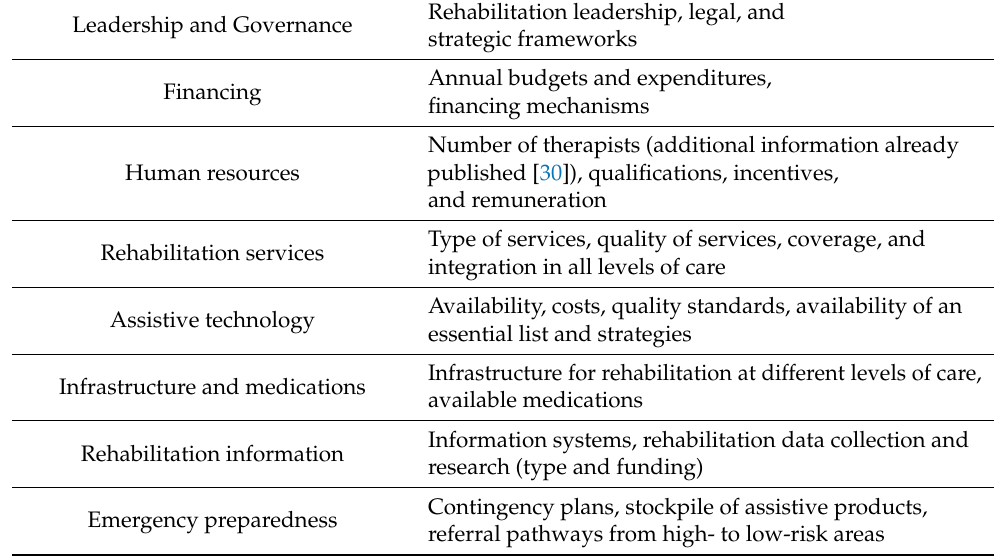
Table A1. TRIC elements applied in this